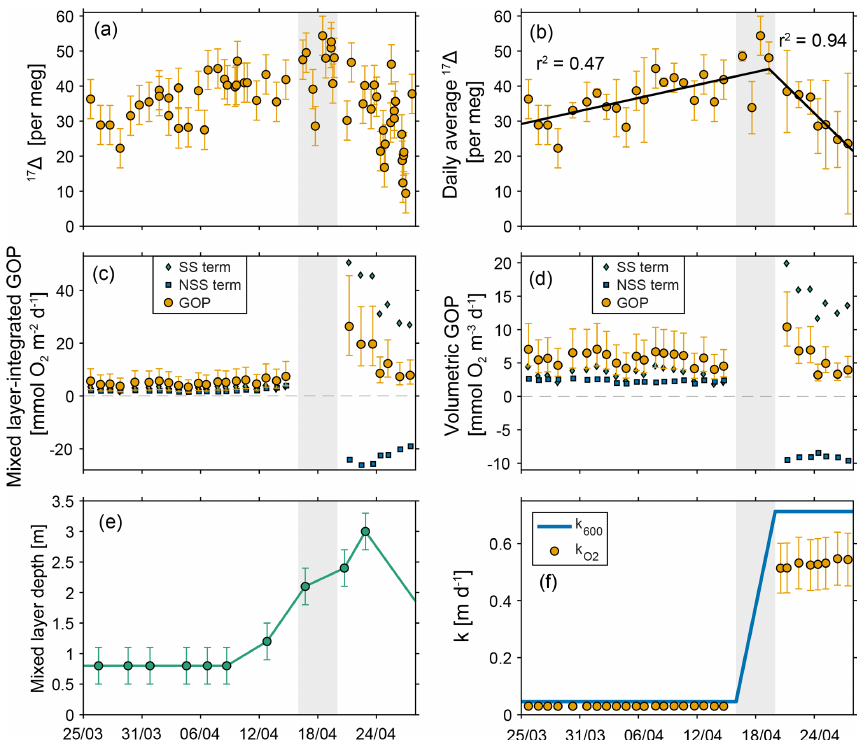
Figure 6. Gross oxygen production at Little Narrows. Gross oxygen production at Little Narrows and data used in the calculation. 17 (cid:49) measurements from (a) all samples and (b) daily averaged values with the two linear regressions shown. Gross oxygen production in (c) mixed layer-integrated and (d) volumetric units. The green diamonds and blue squares show the values of the two terms in the GOP calculation (steady state, SS, and non-steady state, NSS), and the yellow circles show the total GOP (the sum of the two terms). Error bars are only shown on the total GOP for clarity. The SS and NSS terms are slightly offset in time to make it easier to see both terms at the start of the time series. (e) Mixed layer depth. (f) Gas transfer velocity for a gas with a Schmidt number of 600 (blue line) and for O 2 (yellow circles), which has a variable Schmidt number based on temperature and salinity. The shaded grey area is the period where we do not calculate GOP due to uncertainties related to the rapidly melting ice cover and non-steady-state